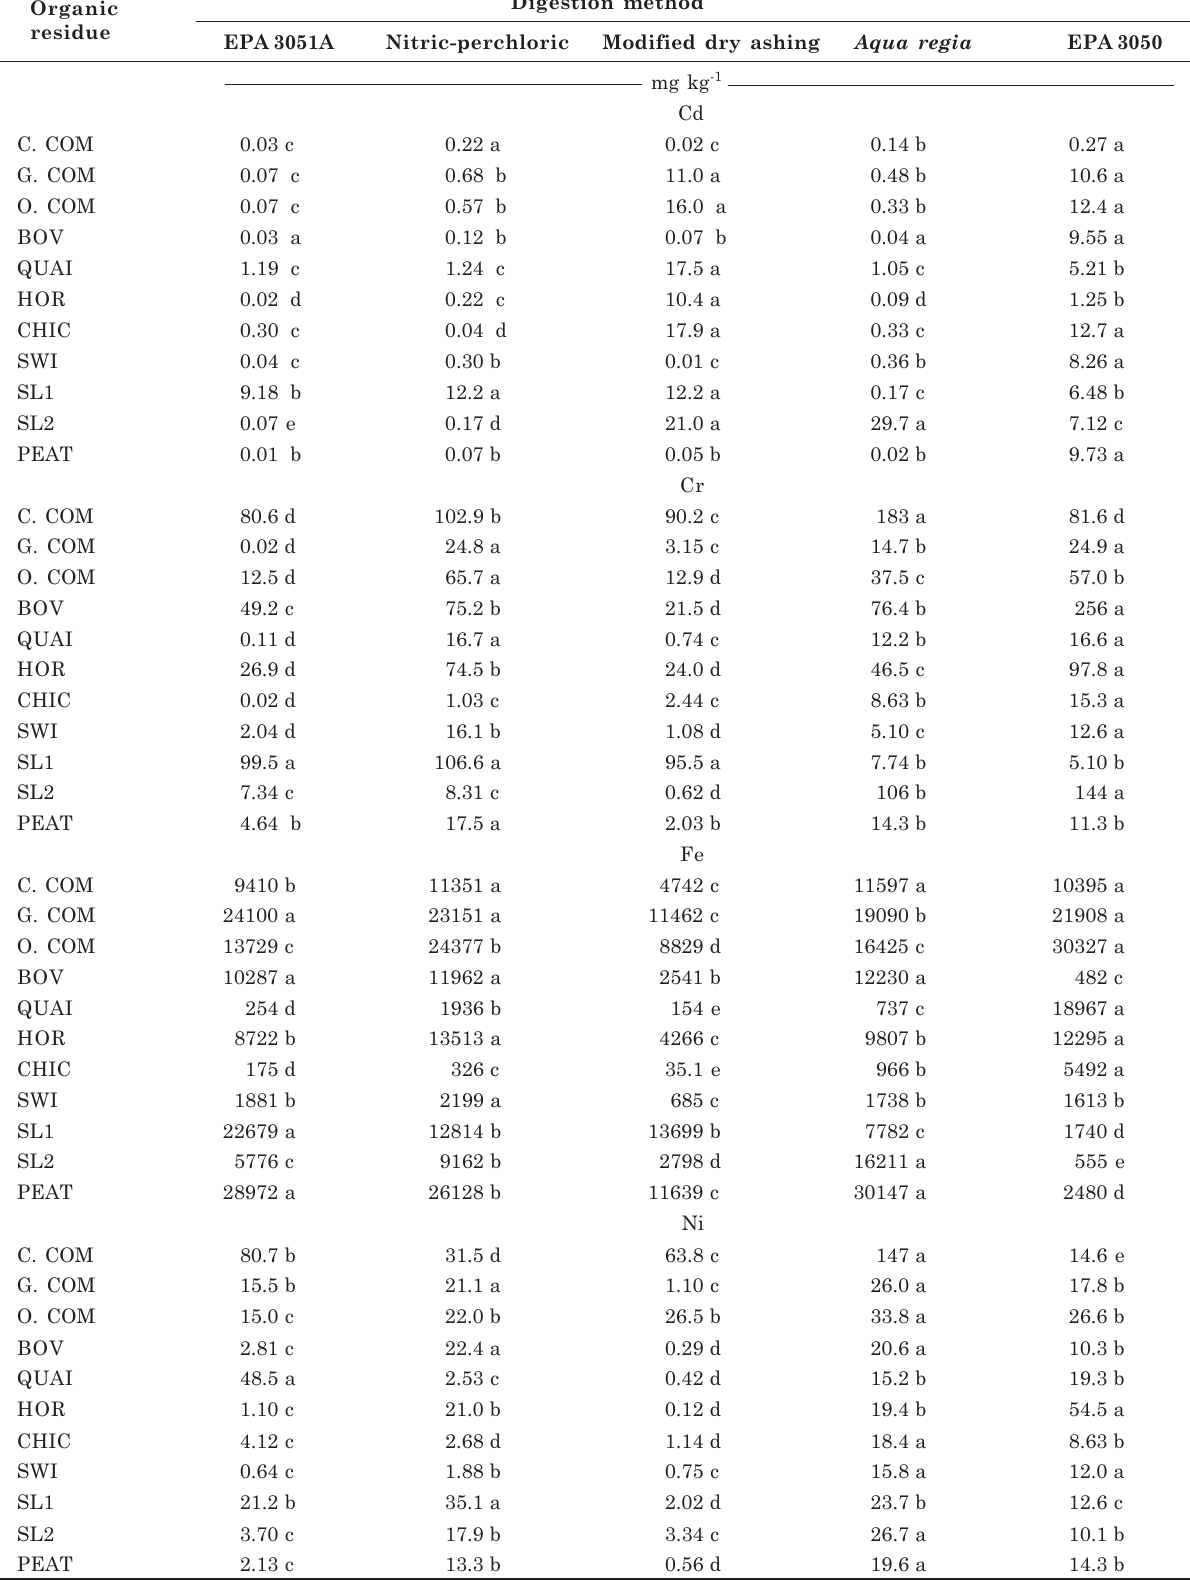
Table 2. Contents of trace elements (TEs) in 11 organic residues after use of the five digestion methods